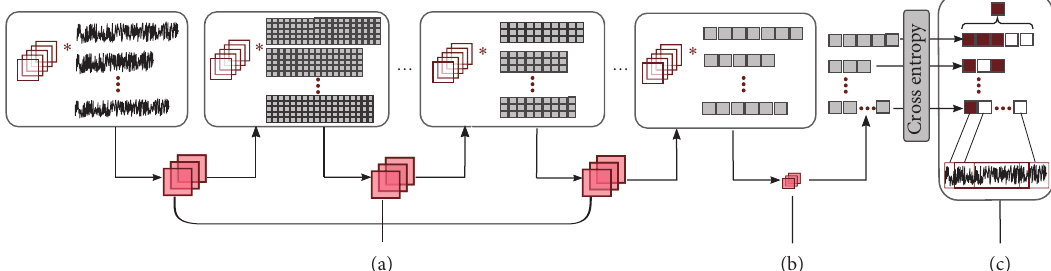
Figure 1: The TOO approach: (a) convolutional implementation of sliding time windows; (b) 1 × 1 convolutional layer; (c) quorum voting.